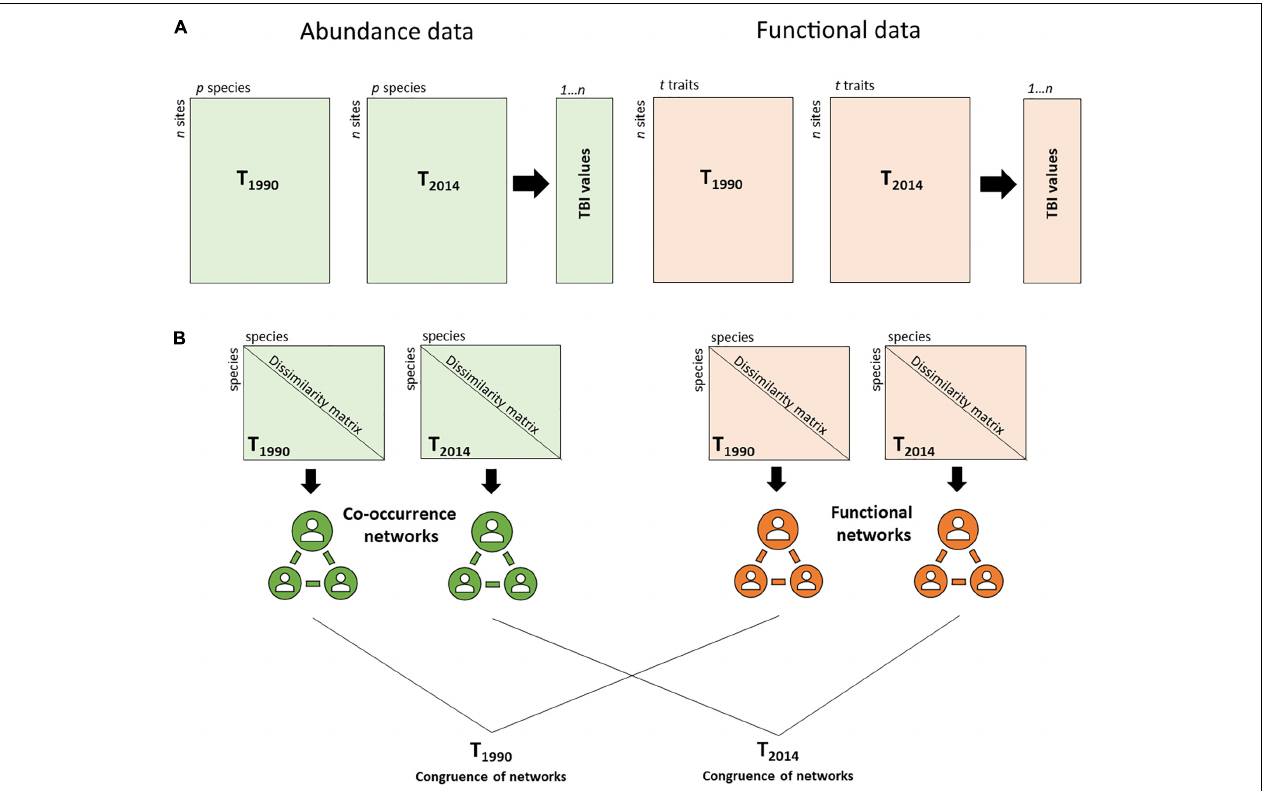
FIGURE 1 | Methodological approach (A) comparing temporal taxonomic and functional beta diversity (TBI) for two time periods, 1990 and 2014, (B) assessing the congruence of the co-occurrence and functional networks to determine the main assembly rules of benthic communities for 1990 and